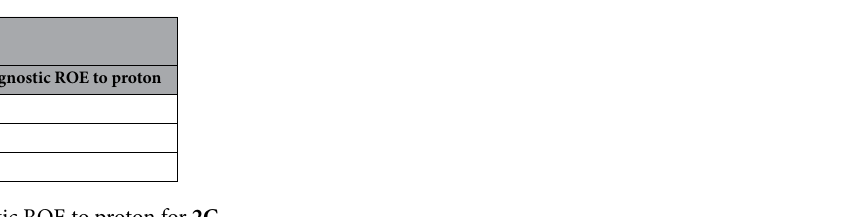
Table 6. Diagnostic ROE to proton for